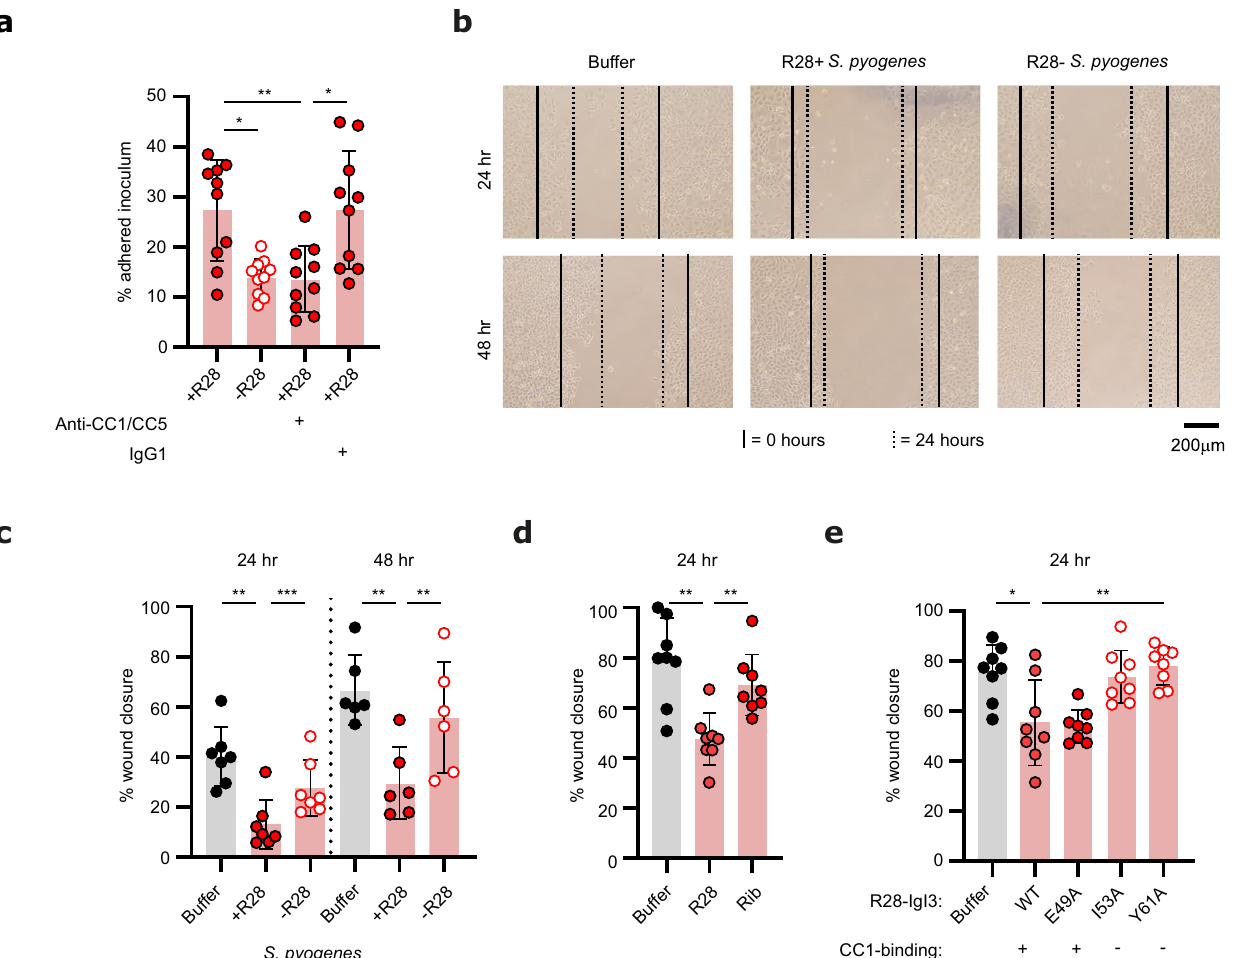
Fig. 4 | R28 promotes adherence of S. pyogenes to human cervical epithelial cells and suppresses wound closure through a CEACAM1-dependent mechan- ism. a Adherence of isogenic S. pyogenes AL368 strains to ME-180 cells at a multi- plicity of infection (MOI) of 10, in the presence or absence a monoclonal antibody (mAb) speci fi c to human CC1 and CC5 N-terminal (mean±s.d. of n =10 indepen- dent experiments). Statistical signi fi cance tested by one-way ANOVA with Tukey ’ s post-hoc test(+R28vs. − R28* p =0.0142,+R28vs.+R28+anti-CC1/CC5** p